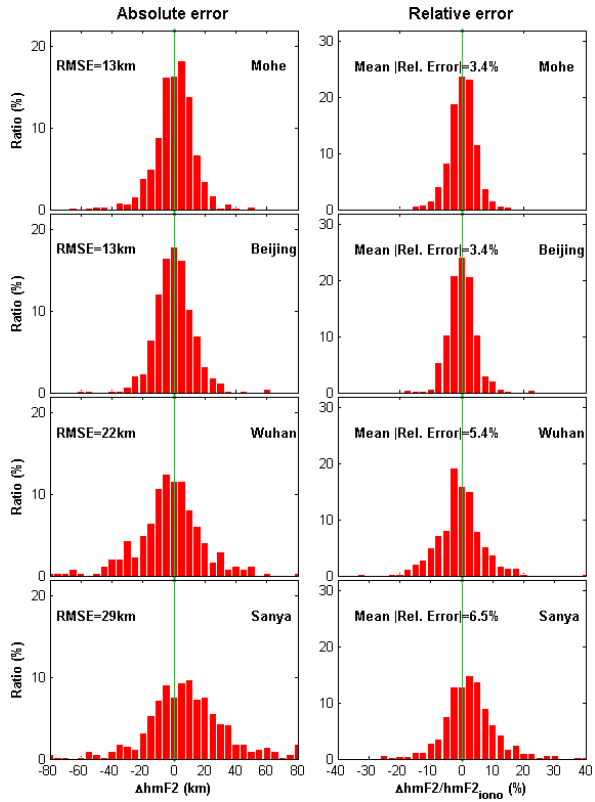
Figure 5. The same as Fig. 4 but for hm F2s.